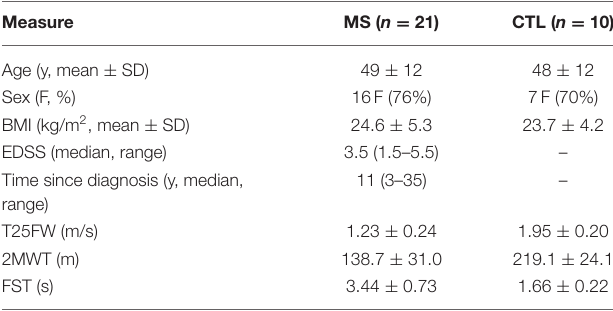
TABLE 1 | Demographics and functional mobility descriptors of MS group and CTL